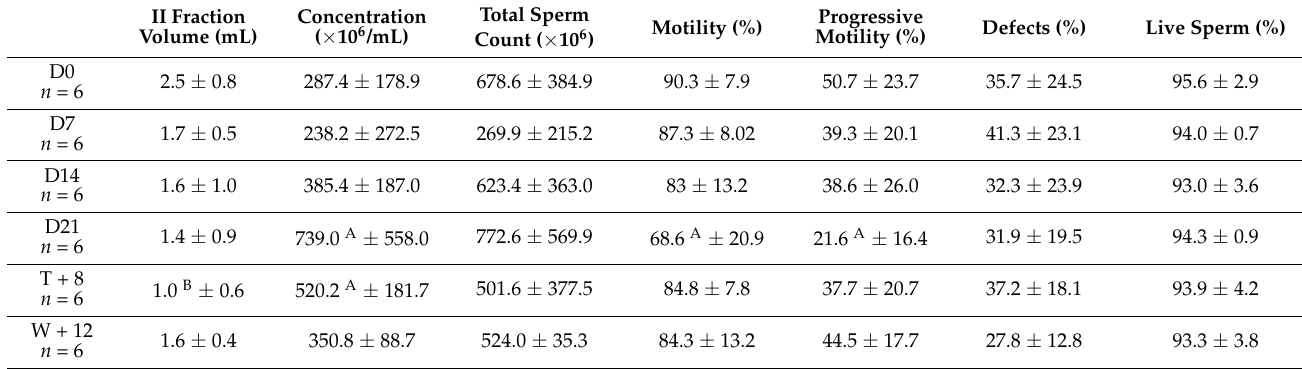
Table 5. Values of qualitative and quantitative parameters of the sperm fraction II samples collected from dogs in Group IV (BPH treated with Osaterone Acetate—YPOZANE ® VIRBAC ® )—comparison in relation to the study on day 0 ( n = 6). Results presented as mean ± SD ( A p < 0.05; B p < 0.01).